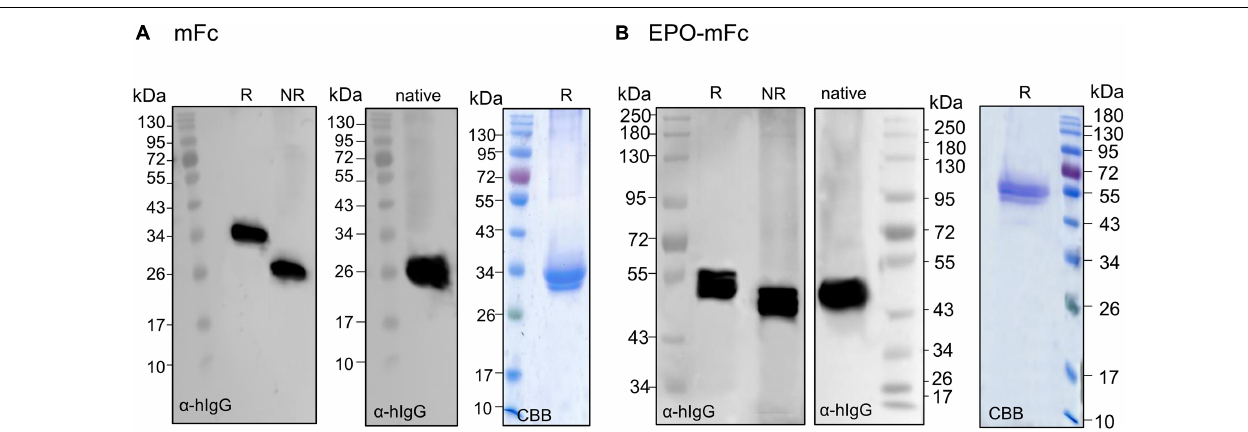
FIGURE 5 | Analysis of the expression of monomeric EPO-mFc fusions. Total soluble proteins (TSP) extracts from N. benthamiana (cid:49) XTFT leaves expressing mFc (non-fused) were analyzed in 12% SDS–PAGE under reducing (R) and non-reducing (NR) conditions and in native PAGE with anti-hIgG antibodies. (A) mFc purified out of TSP with protein G was stained with Brilliant Blue under reducing conditions (CBB). (B) EPO-mFc expression was analyzed in reduced (R) and non-reduced (NR) TSP extracts in 8% SDS–PAGE and in native 12% PAGE. EPO-mFc was purified out of TSP with protein G and stained with Coomassie Brilliant Blue under reducing conditions (CBB). Protein size markers are shown in kilo Dalton